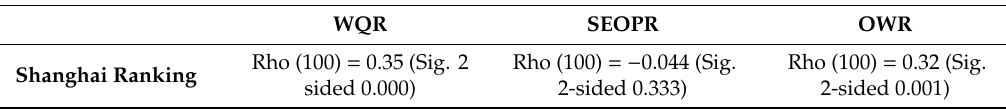
Table 9. Spearman correlation coe ffi cient between the Academic Ranking of World Universities ranking (SEOPR), and overall web ranking